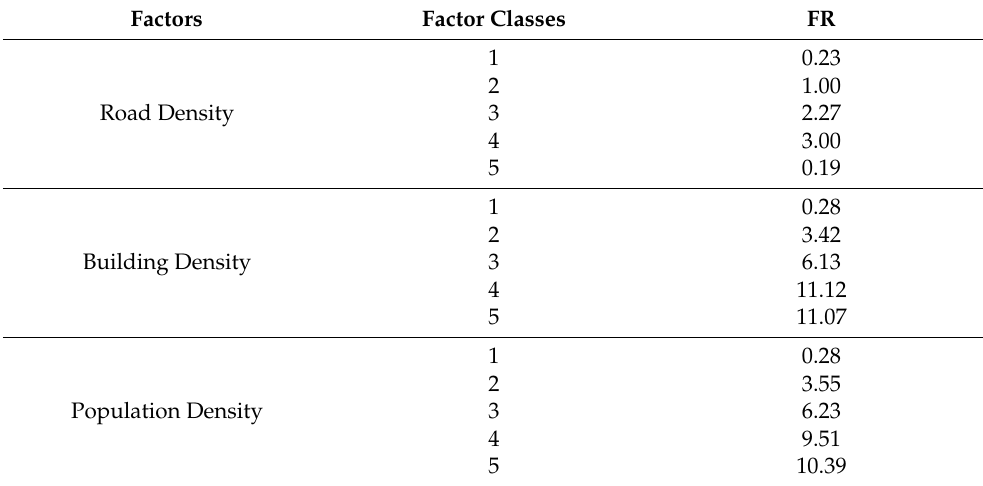
Table 8. Frequency ratios and predictive weights for the factors used in FR model used for vulnera- bility